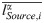
Countries-products matrix reporting countries’ trophic levels in different OFNs with different products.Rows (countries) and columns (products) are arranged in descending order of n, and then lSource,iα¯, where n and lSource,iα¯ are the number of colored points and the mean of trading trophic levels respectively.